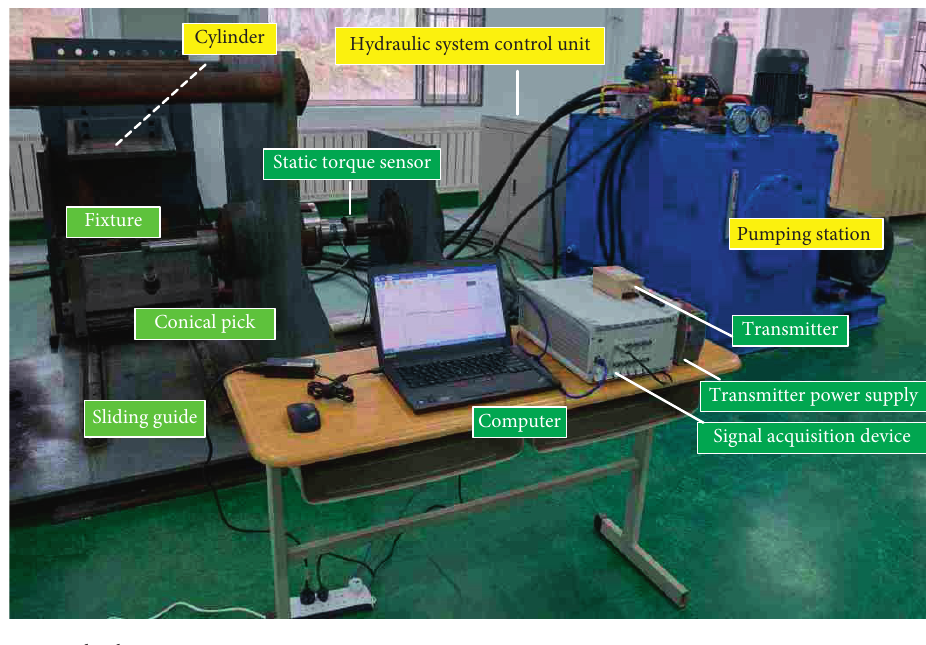
Figure 6: Rock plate cutting testbed [30].